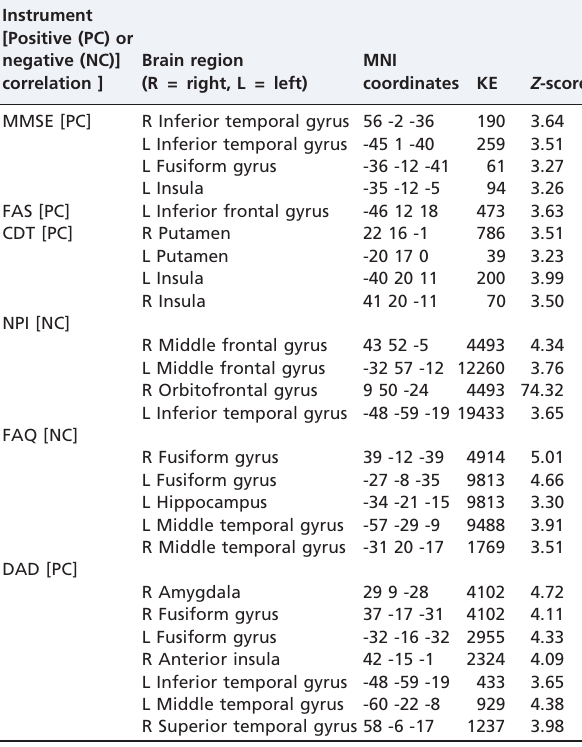
Table 2 - Neuroimaging findings, cognitive, behavioral, and functional scores